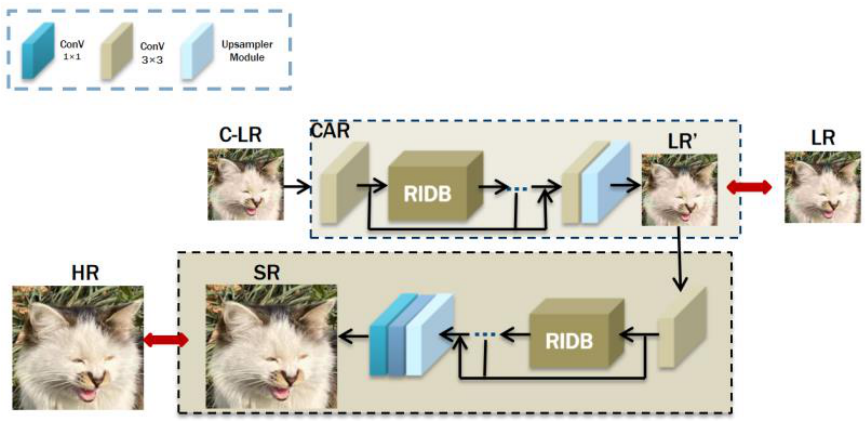
Figure 2. The overall pipeline of the proposed super-resolution reconstruction network.